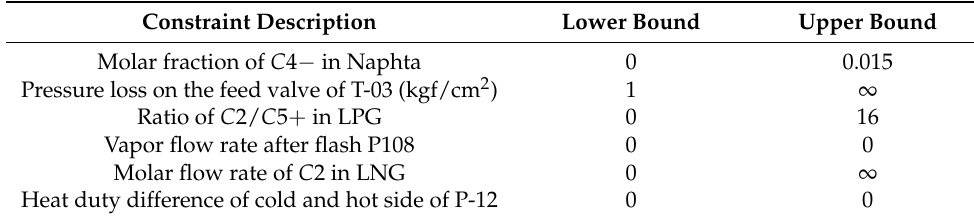
Table 2. Input variables and parameters for the data reconciliation simultaneous with the parameter estimation problem. Degree of Freedom Weight ( w u ) Lower Bound Upper Bound Bottom flow rate of tower T-03 (kmol/h) − 0 100 Reflux flow rate of tower T-03 10 2 DCS DCS Recirculation flow rate of tower T-03 10 2 DCS DCS Murphree Efficiency of tower T-03 − 0.8 1 Heat duty of P-12 ρ 1 (Mcal/h) − 10 500 Parameter θ 1 − 0 1 Parameter θ 2 − 0 1 Parameter θ 3 − 0 1